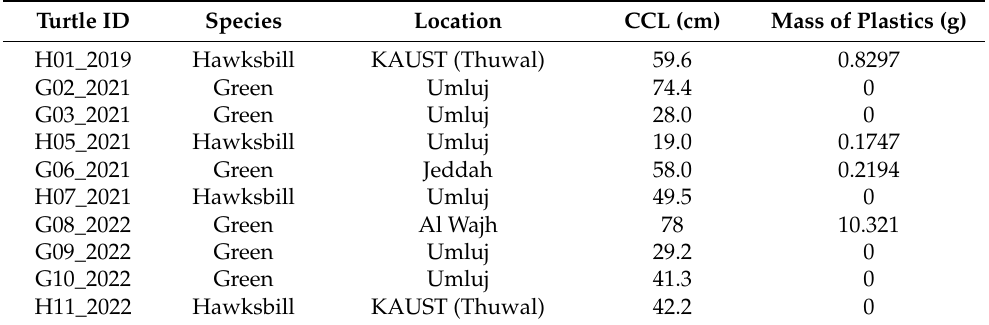
Table 1. Information on the unique ID, species, location of the deceased turtle, curved carapace length (CCL), and the mass of the plastics (g) found in each turtle’s digestive